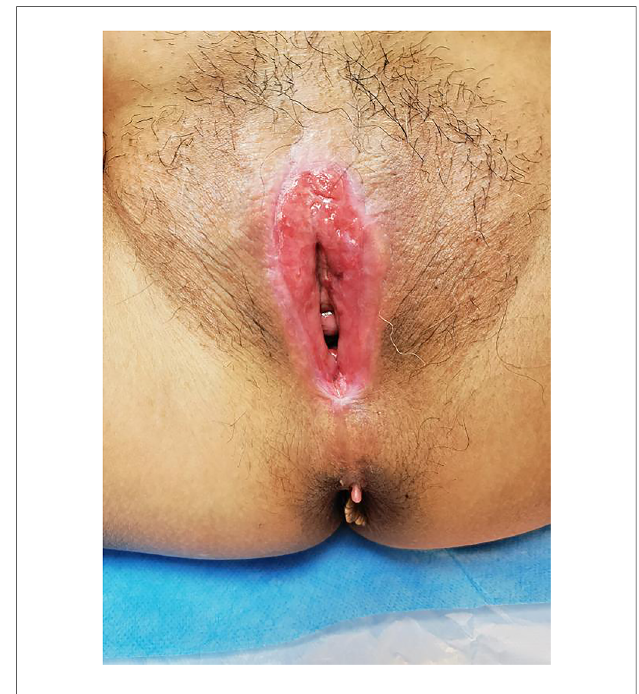
FIGURE 5 The separated wound surface was healed and formed a smooth surface.